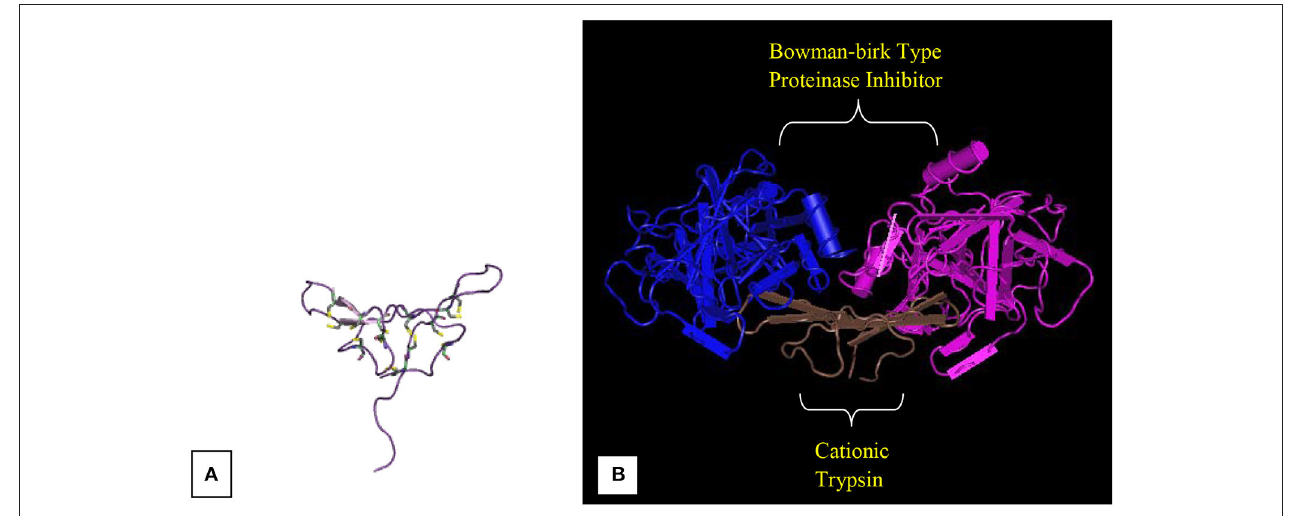
FIGURE 3 | Bowman-Birk inhibitors of Medicago scutellata . (A) IBB_MEDSC-Bowman-Birk type protease inhibitor (PDB id: 1mvz). (B) The anticarcinogenic Bowman-Birk inhibitor from snail medic ( Medicago scutellata ) seeds complexed with bovine trypsin ( Capaldi et al., 2007).